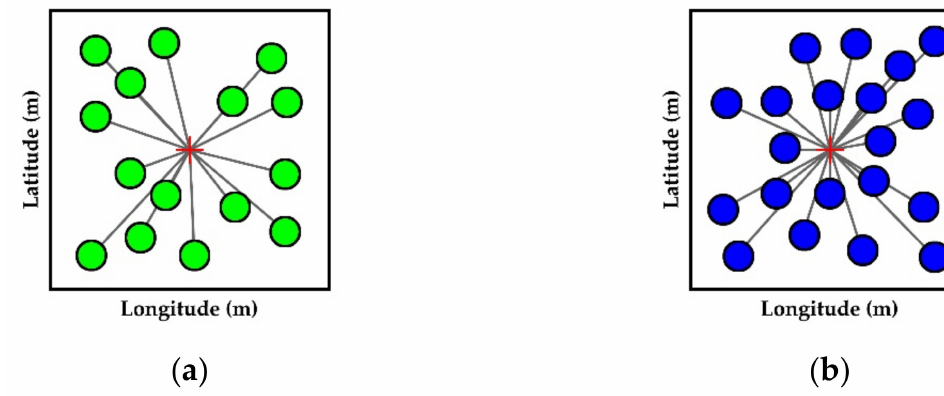
Figure 1. We compared the spatial pattern similarity of two point data sets by measuring PDF similarities for the distance ( δ ) and angle ( θ ) from the centroid of the extent (red cross) to each point of each data set ( a , b